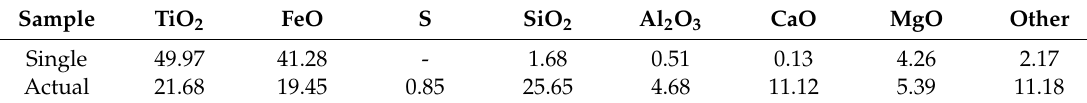
Table 1. The results of chemical composition analysis of mineral samples (%).